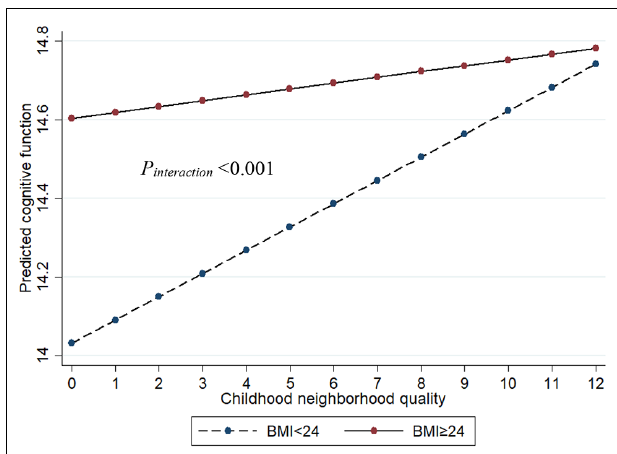
FIGURE 2 | The interaction between BMI and CNQ on cognitive function. Age, sex, education, marital status, smoking, drinking, exercise, family income, urban, and depressive symptoms were adjusted in the model.